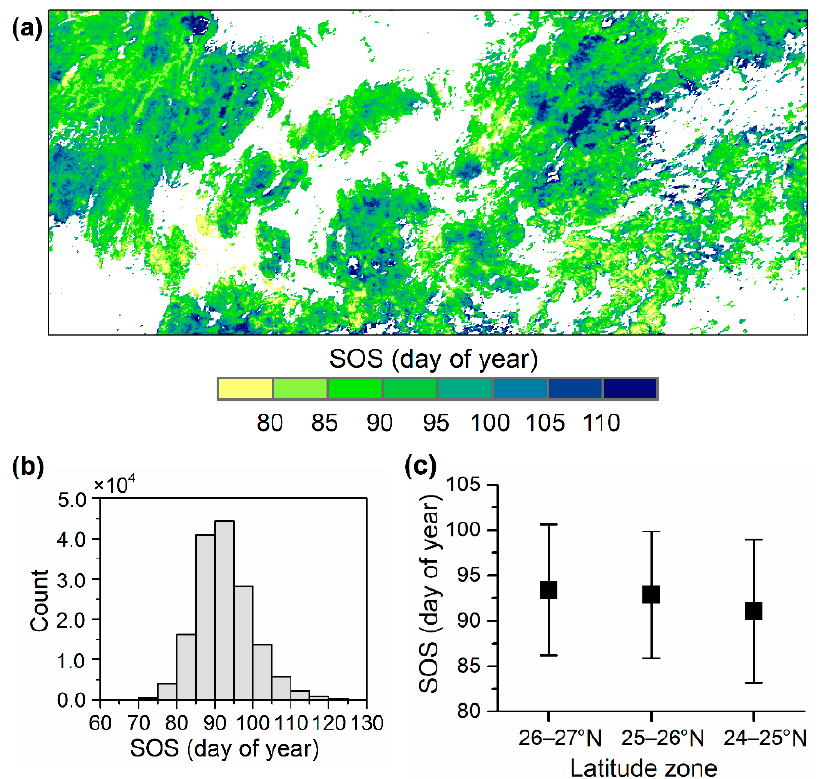
Figure 2. Spatial pattern of the start of the growing season (SOS) over the Nanling Mountains. ( a ) Spatial distribution of the multiyear mean SOS for the period of 1999–2019, ( b ) the frequency distribution of the multiyear mean SOS, and ( c ) the regional mean SOS and the standard deviation for each latitude zone.